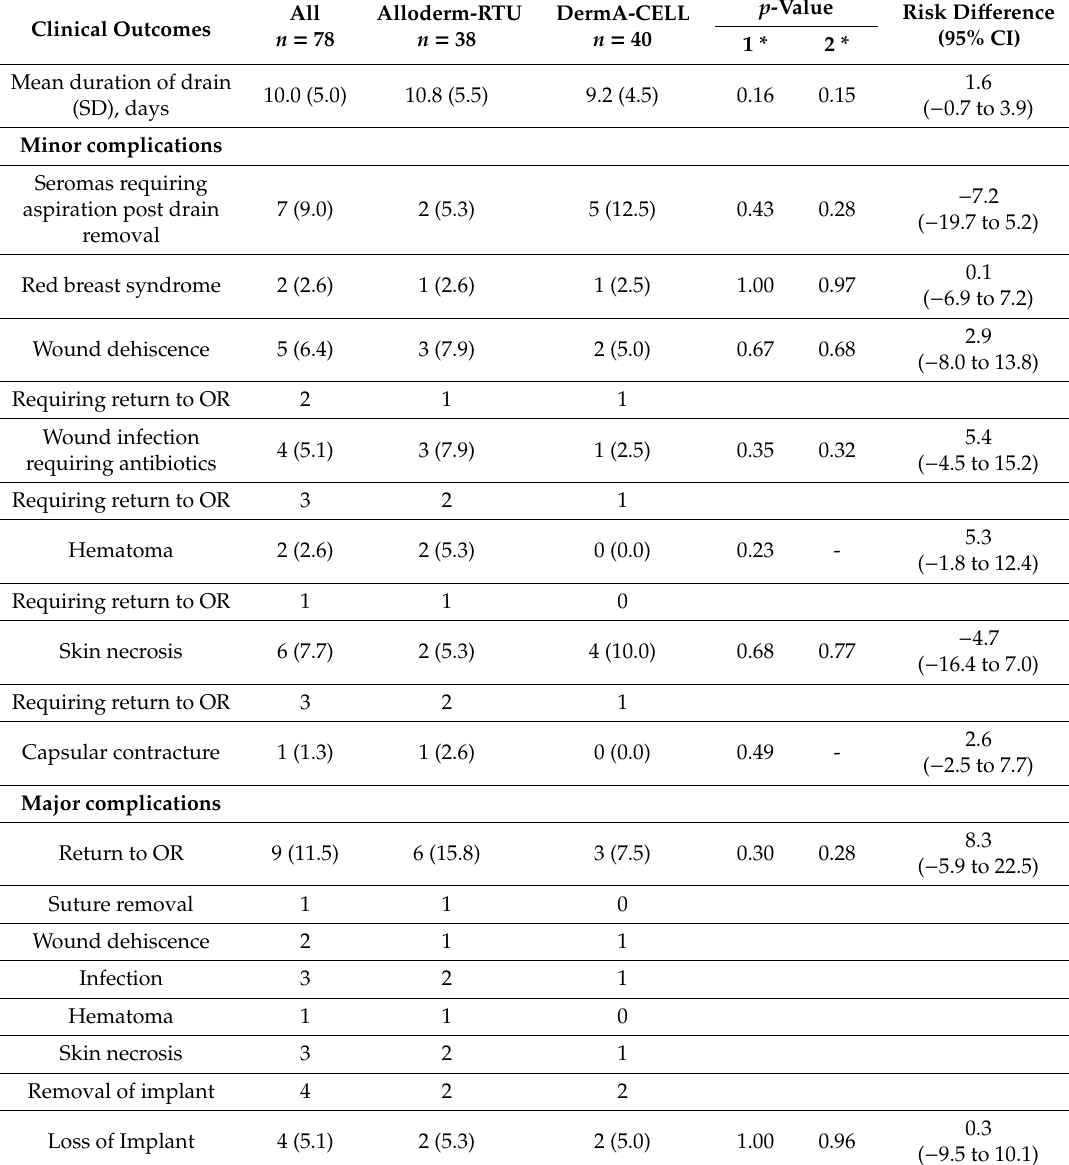
Table 3. Clinical endpoint data. All values are number (percentage) unless otherwise